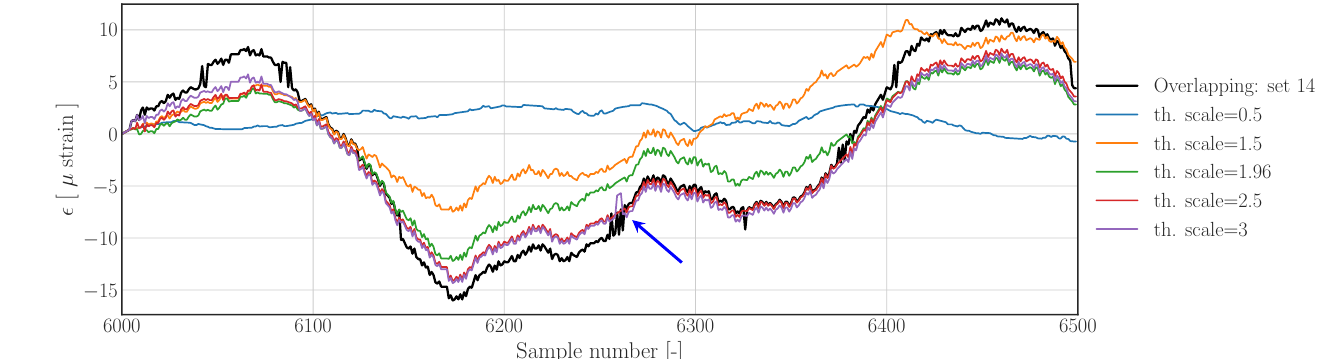
Figure 17. Raw strain time series (black) and Hampel filter-based reconstructions at different levels of the threshold scale parameter. The lower the scale parameter the more samples will be detected as outliers, hence the more emphasis is put on the outlier reconstruction